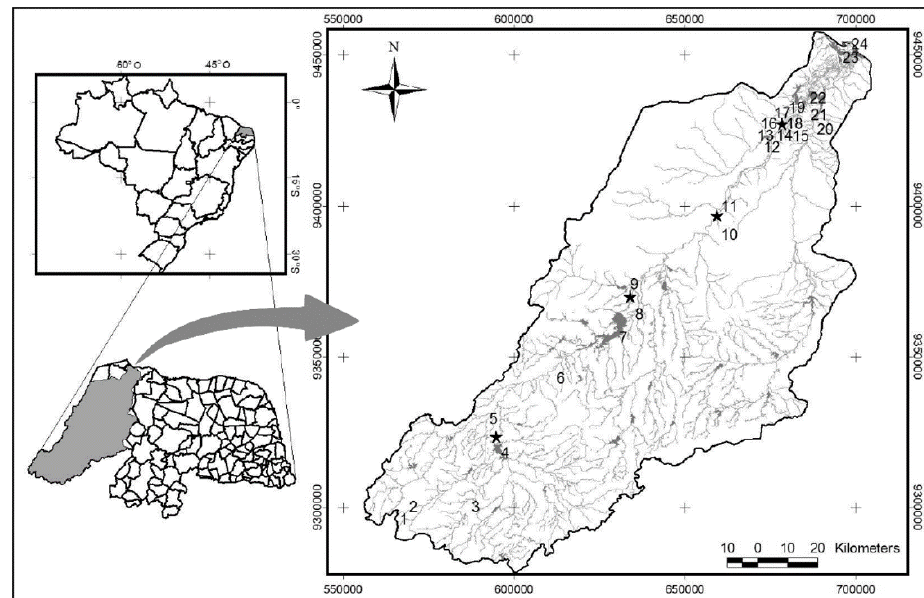
Figure 1. Localization of the sampling points in the Apodi/Mossoró river hydrographic basin, semiarid of Rio Grande do Norte, Brazil, with highlights of water bodies (reservoirs and impoundments). Black stars mark the major cities.